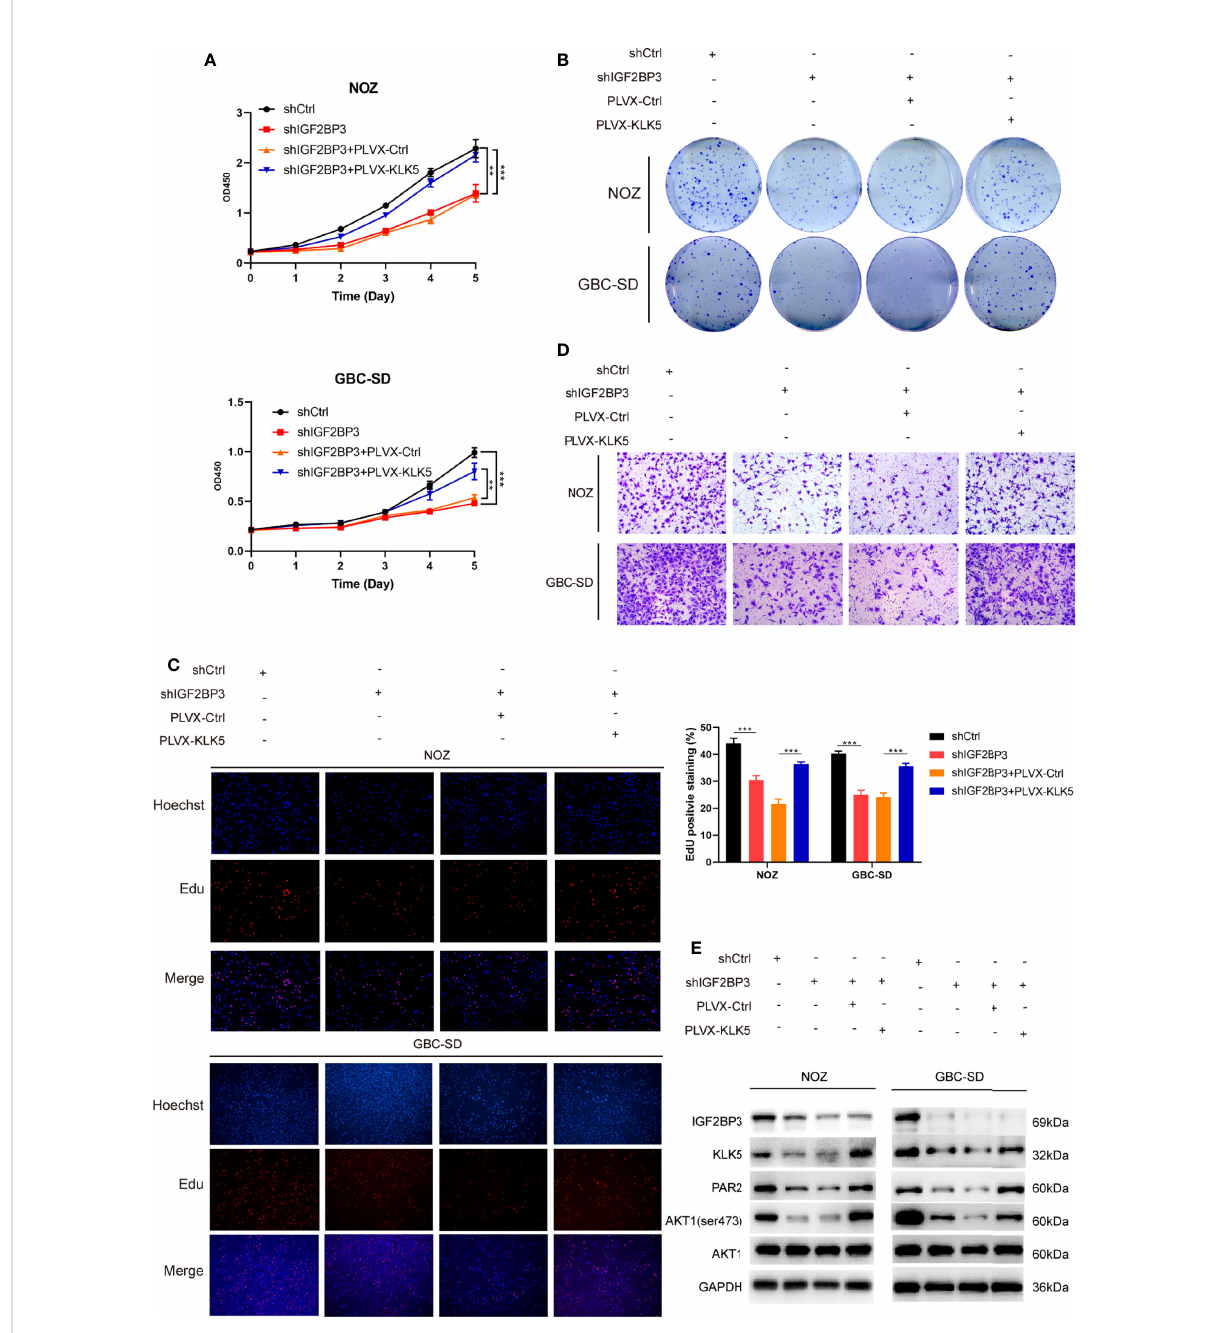
FIGURE 5 KLK5 rescued the abrogated GBC progression in IGF2BP3-depleted cells. (A – E) IGF2BP3-depleted GBC cells were co-transfected with PLVX- KLK5 or control plasmid. Cell growth ability was assessed by CCK8 assay (A) , colony formation assay (B) and EdU assay ( C , 100X, scale bar: 100 m m). Statistical signi fi cance was analyzed based on the number of EdU stained cells (right). (D) Transwell assays were conducted to compare the migration ability in each treated group of GBC cells (100X, scale bar: 100 m m). (E) Western blotting assays showed the expression of IGF2BP3, KLK5, PAR2, p-AKT1 (ser473) and AKT1 in different treatment groups, GAPDH was used as the endogenous control. Unpaired t test was used in (A, C) Data is shown as mean ± SD; ** P < 0.01 and *** P <